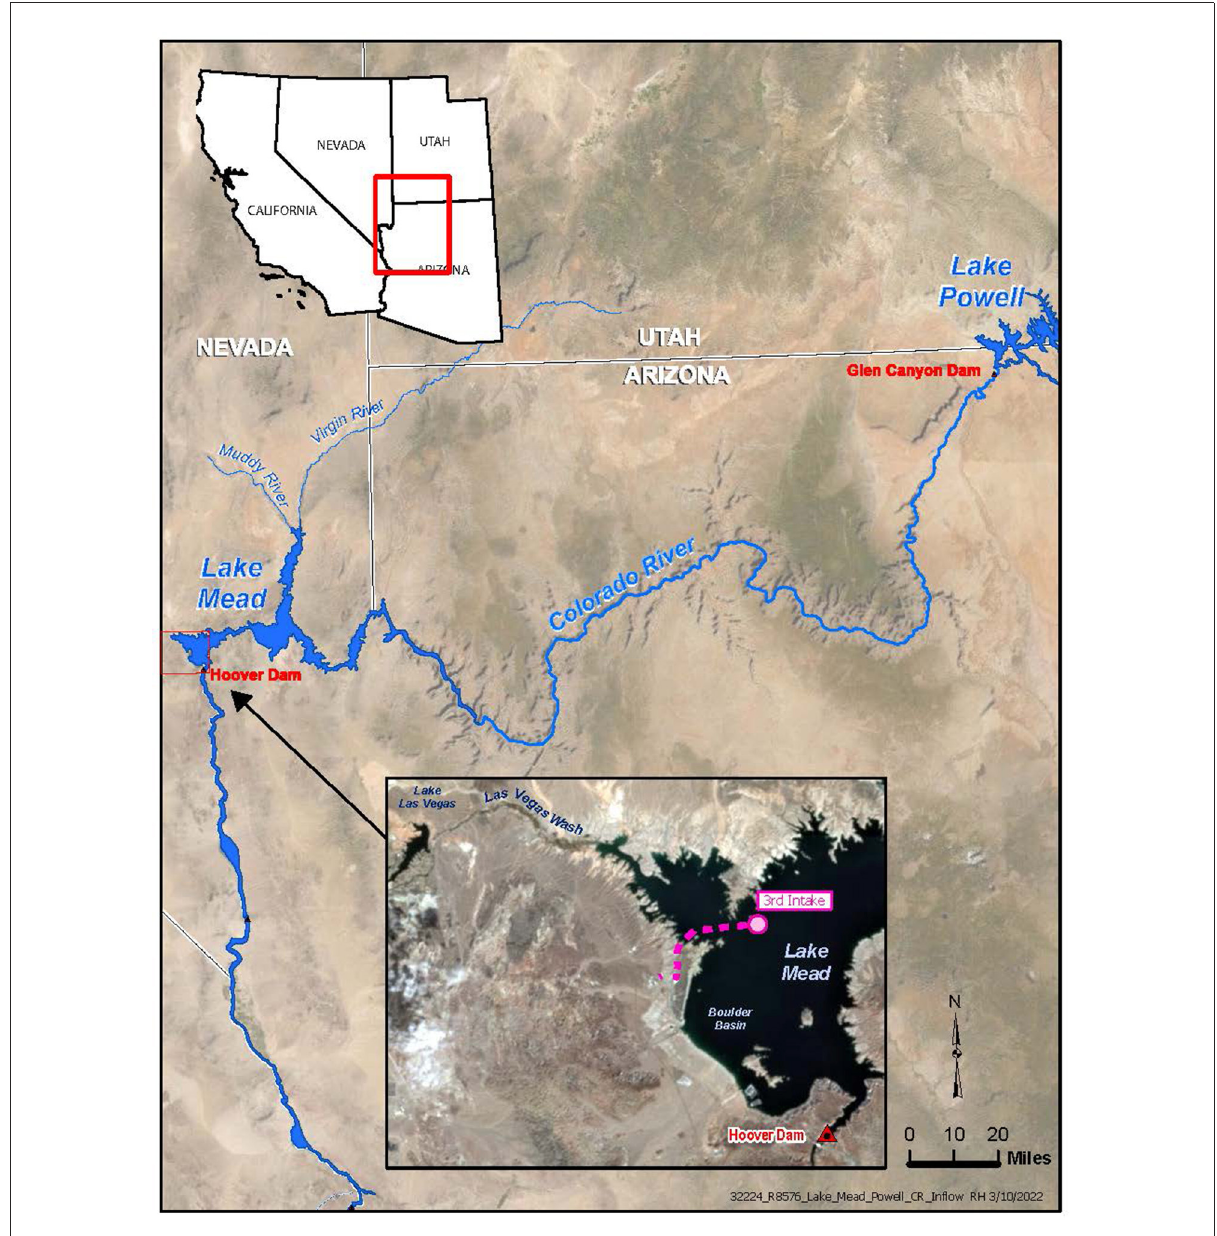
FIGURE1 Map of Lakes Powell and